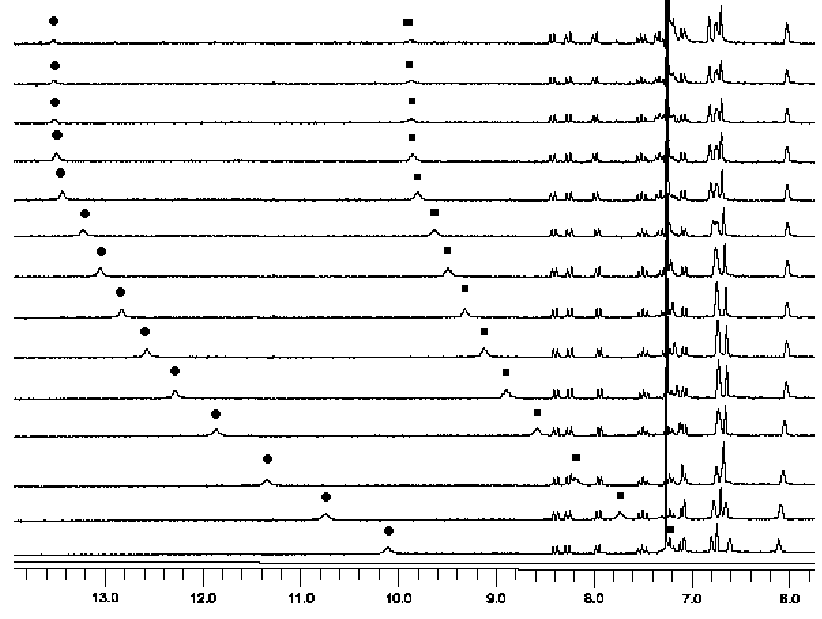
Table 1. Association constants of receptors 1 and 2 with bis-TBA salts of bis-carboxylate anions in CDCl